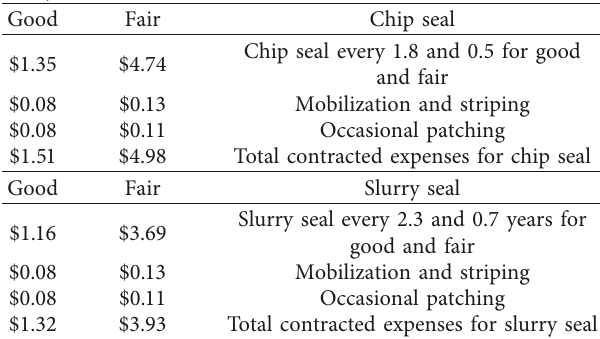
Table 3: EUAC per SY and admin expenses for chip seals and slurry